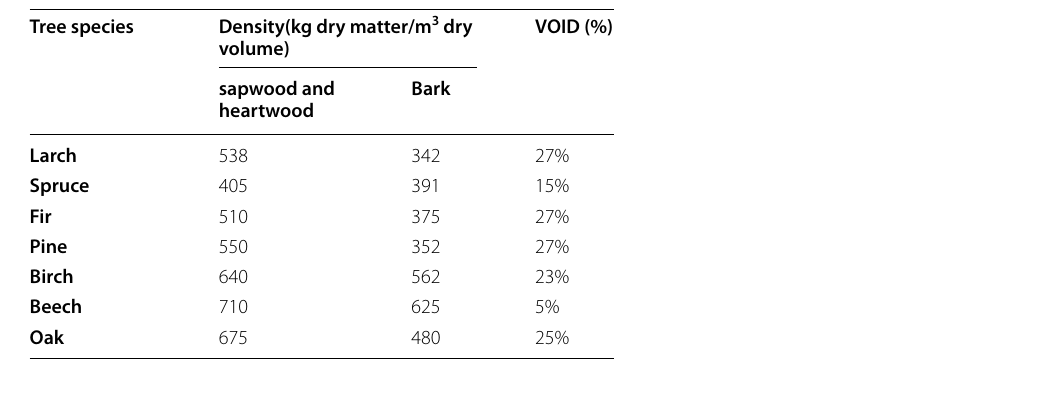
) and of diameter of heartwood (D ) with diameter of stem th h